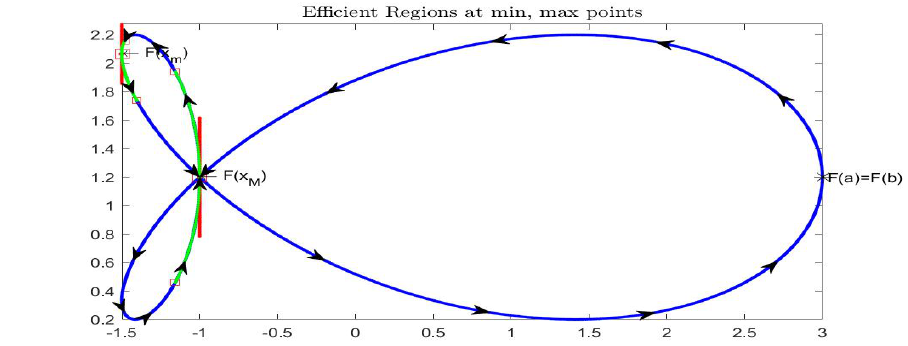
Figure 23. Periodic Example 3 (big fish): function F ( x ) is pictured on top and functions (cid:98) f ( x ) , (cid:101) f ( x ) on bottom . Marked points correspond to x m and x M , where the two functions are differentiable.